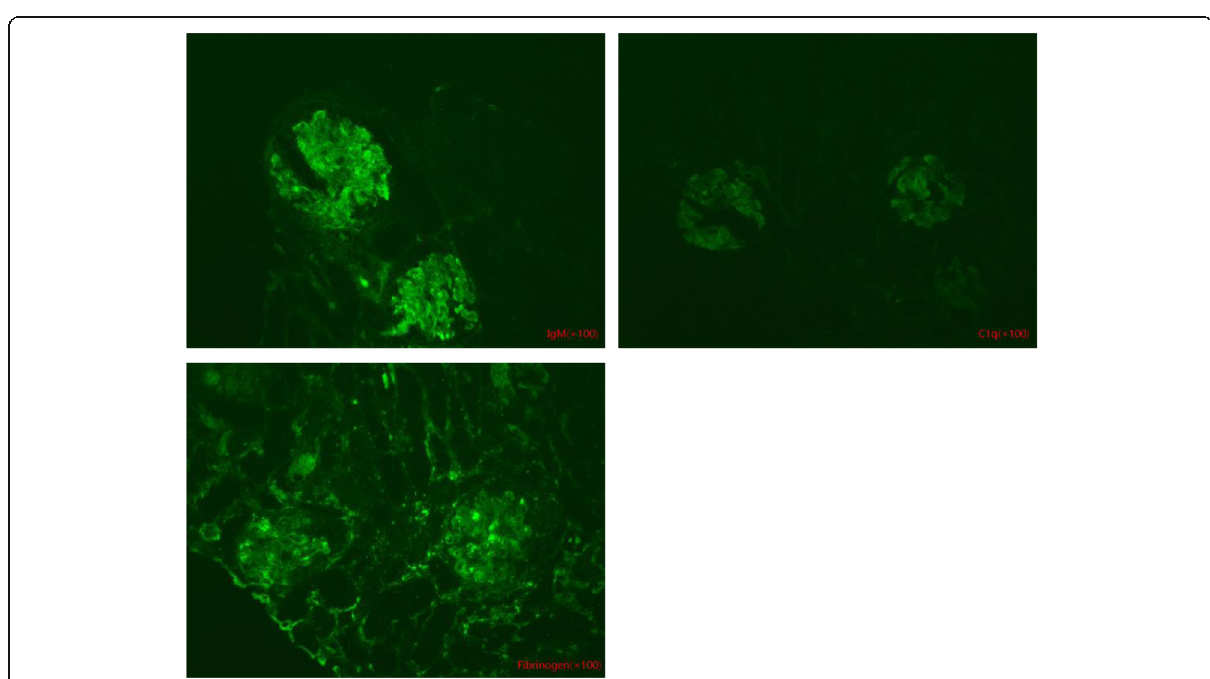
Fig. 2 Immunofluorescence analysis of renal biopsy. Diffuse granular deposition of IgM (3+), C1q (+) and fibrinogen (+) along the glomerular mesangium and capillary loops